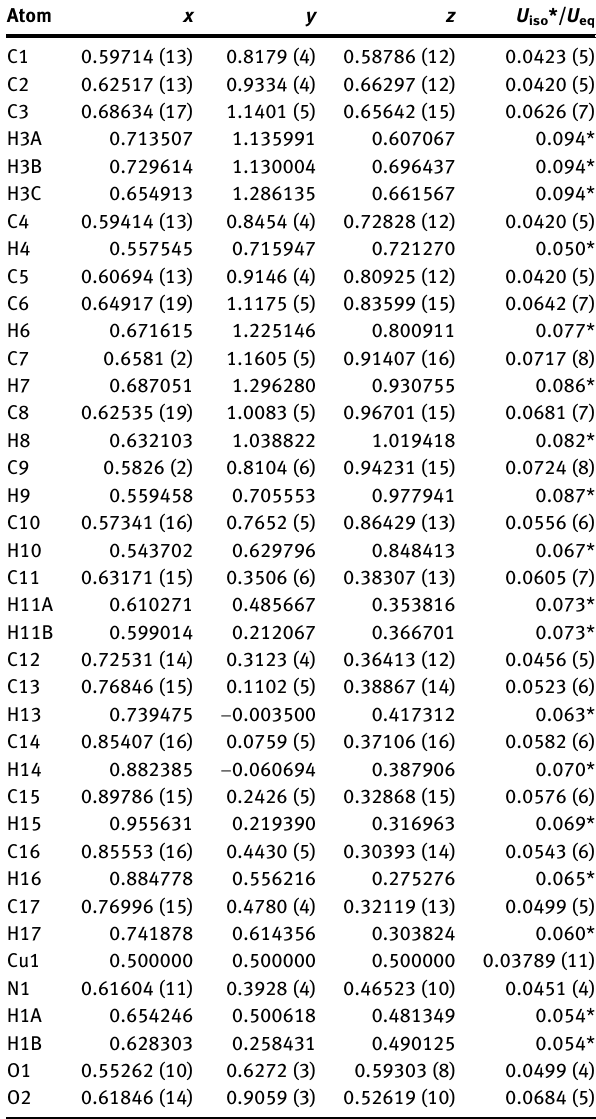
Table  : Fractional atomic coordinates and isotropic or equivalent isotropic displacement parameters (Å 